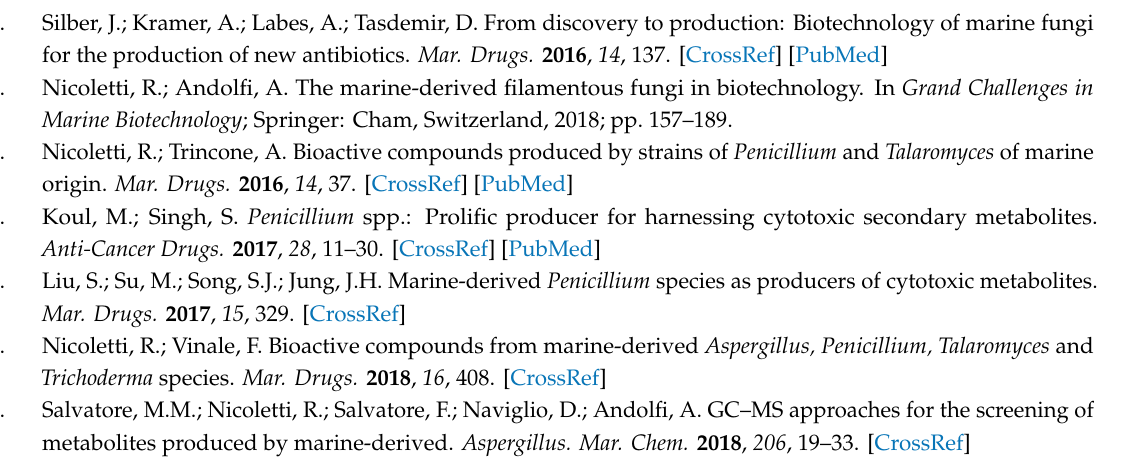
Metabolite identification, Figure S1. LC-MS chromatogram of crude extract, Figures S2–S6. NMR spectra of cis -bis(methylthio)silvatin and mycophenolic acid, Figure S7. EI mass spectra at 70 eV of 1 – 9 , Figures S8–S15. ESI-MS mass spectra of 1 – 9